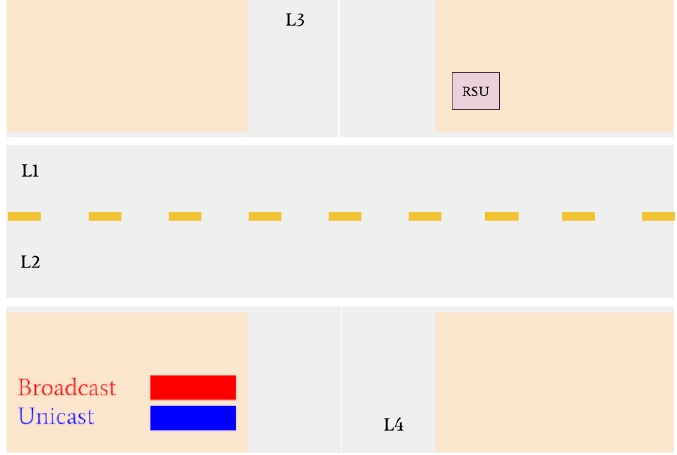
Figure 23. All vehicles have left the intersection and the simulation is